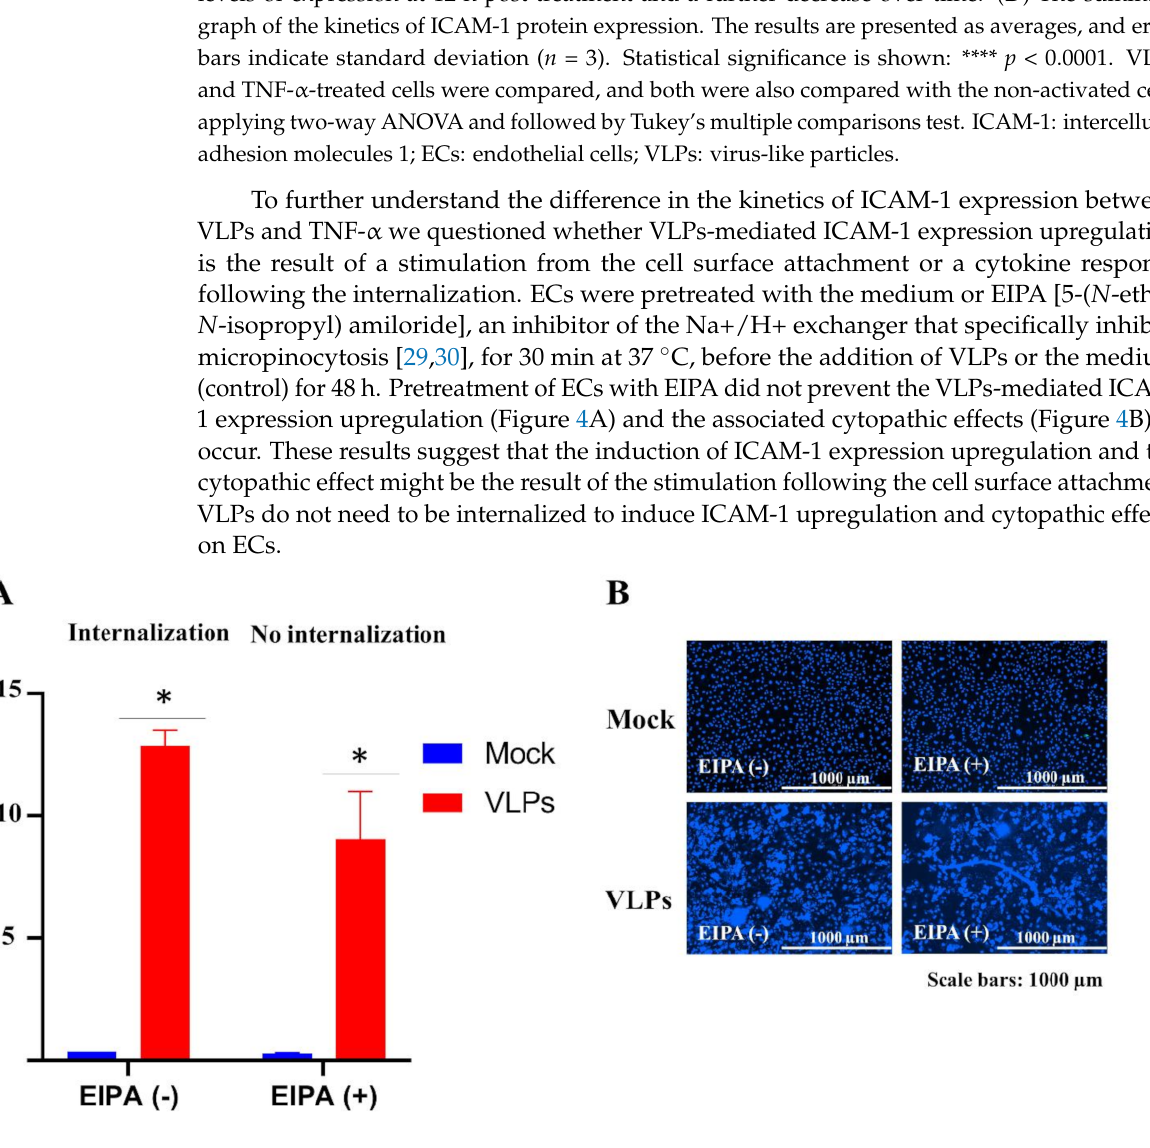
Figure 4. Micropinocytosis inhibition did not suppress VLPs-induced ICAM-1 upregulation and associated cytopathic effects. ECs were pretreated with 10 µ M EIPA for 30 min at 37 ◦ C before the addition of VLPs. The cells were incubated for 48 h at 37 ◦ C, and the expression level of ICAM-1 on ECs and the morphology of ECs were assessed using immunofluorescence and nuclei staining, respectively. ECs treated with the medium (mock) were used as control. ( A ) Graphic representation of ICAM-1 expression. ( B ) Images of stained nuclei showing the cytopathic effect following the exposure to VLPs. Data are the representative of two experiments performed in duplicate and are presented as the mean ± SD. Statistical significance is shown: * p ≤ 0.05. VLP-treated ECs with EIPA and without EIPA were compared applying two-way ANOVA and followed by Š í d á k’s multiple comparisons test. VLPs: virus-like particles; ECs: endothelial cells; ICAM-1: intercellular adhesion molecules